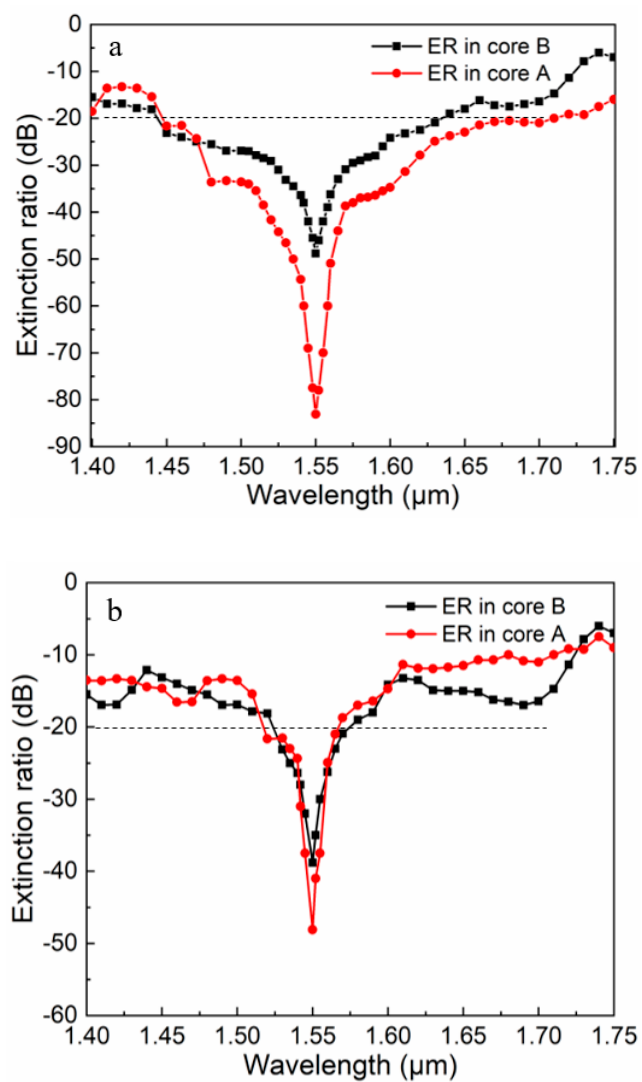
Figure 5. Various extinction ratios (ERs) of the x- and y-pol lights for the proposed PCF-PBS ( a ) with the As 2 S 3 layer and ( b ) without the As 2 S 3 layer versus wavelength when Λ = 2.2 μ m, d 1 = 1.1 μ m, d 2 = 2.2 μ m, and t = 150 nm.